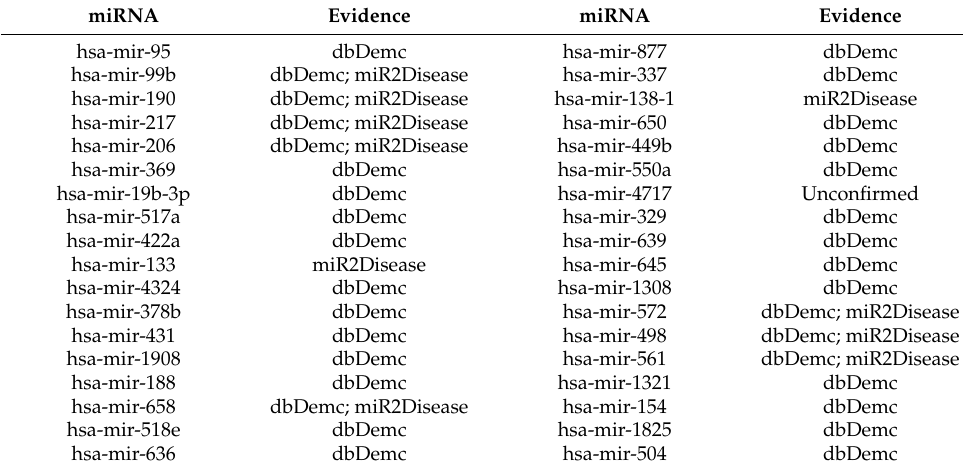
Table 6. Top 50 potential breast neoplasms-related miRNAs, 48 were confirmed by dbDEMC and miR2Disease